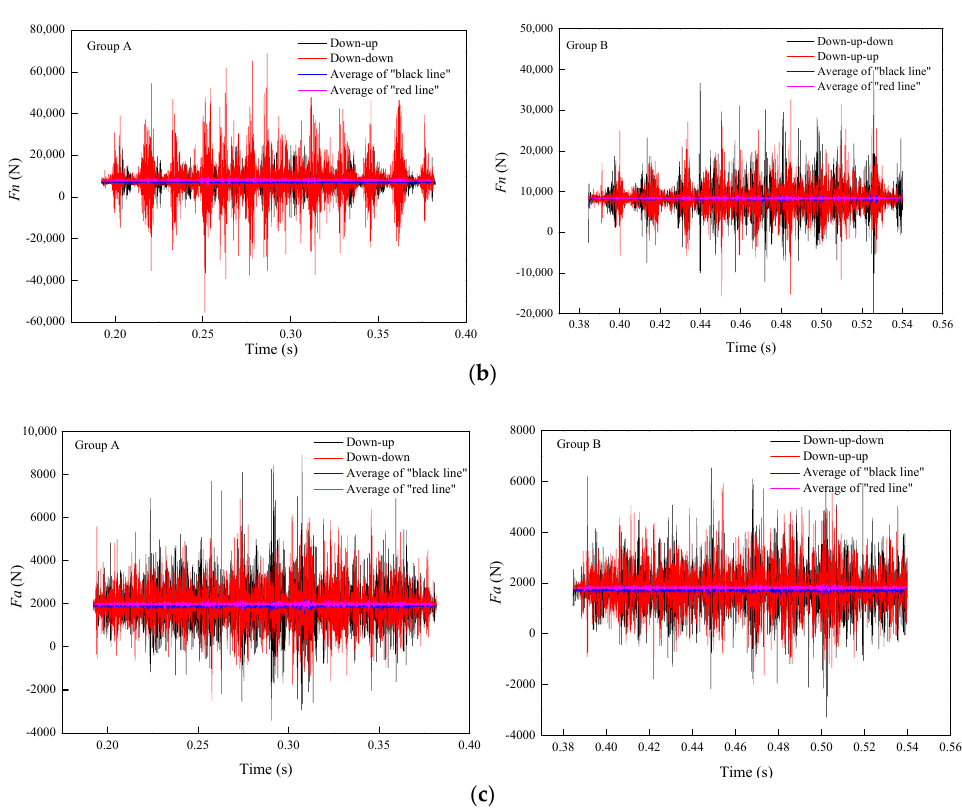
Figure 14. Change in the grinding force with a change in the grinding direction: ( a ) F t , ( b ) F n , and ( c ) F a .